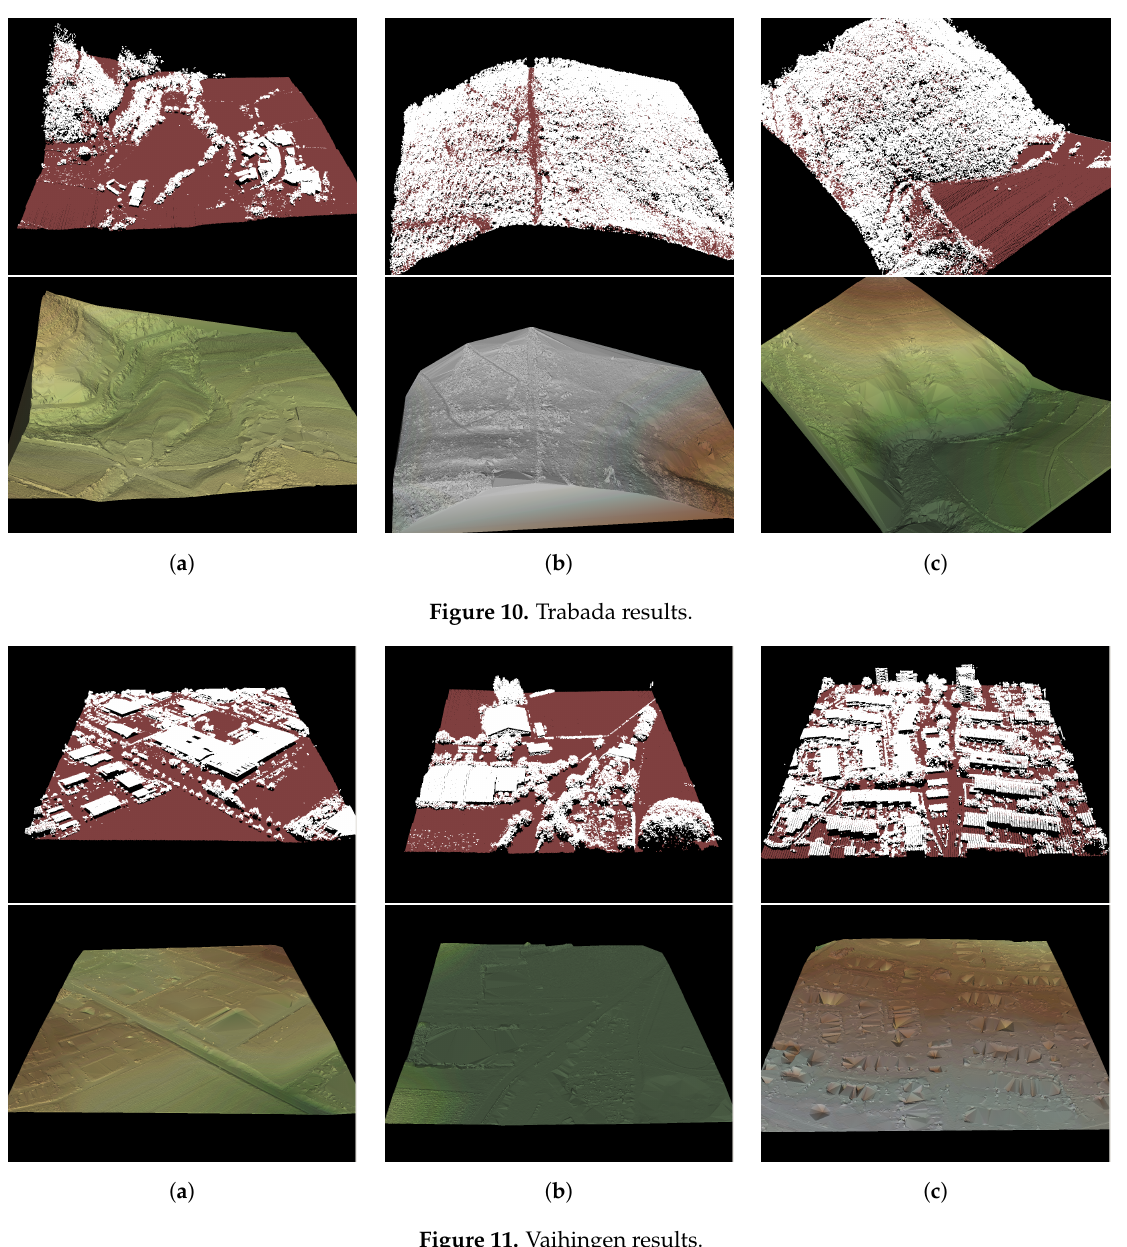
Figure 11. Vaihingen